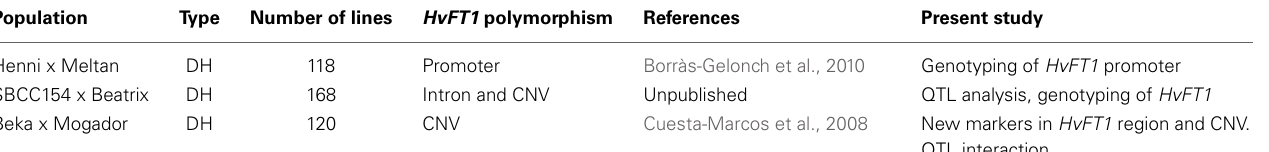
Table 1 | Biparental populations analyzed in this